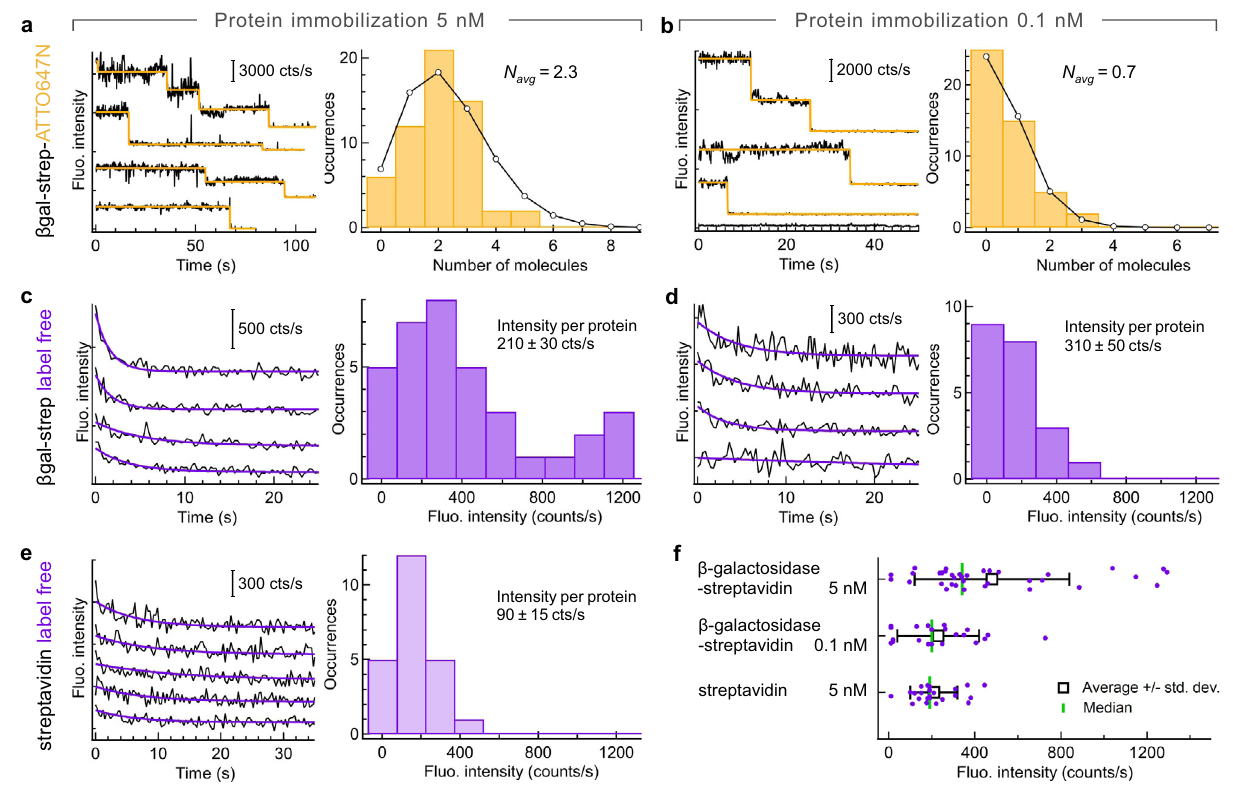
Fig. 2 Horn antenna-enhanced label-free detection of immobilized single proteins. The surface of the horn antenna has been functionalized with biotin- PEG-silane to bind β -galactosidase-streptavidin and pure streptavidin proteins. In ( a , c , e ), the total protein concentration is 5 nM while it is reduced to 0.1 nM in ( b , d ). a , b Additional Atto647N-biotin red fl uorescent label is added as a control to quantify the number of proteins inside individual horn antennas. Typical Atto647N fl uorescence time traces are shown on the left panels in ( a , b ), together with their step-function fi t (yellow line) allowing to count single molecules. The traces are vertically shifted for clarity. The right panels in ( a , b ) display the histogram of the number of detected molecules (bars) together with a Poisson distribution fi t (line and dots). For ( c – f ), the experiments are performed with label-free proteins in the UV using 5 nM β - galactosidase-streptavidin ( c ), 0.1 nM β -galactosidase-streptavidin ( d ) and 5 nM streptavidin ( e ). In ( c – e ), the left panels show auto fl uorescence time traces and their exponential decay fi t recorded on different individual horn antennas (the traces are vertically shifted for clarity). The right panels represent the histogram of the exponential fi t amplitudes. For ( c ) 35 horn antennas were probed, for ( d ) 21 and ( e ) 23. ( f ) Scatter plot of the exponential fi t amplitudes corresponding to the histograms in ( c – e ). The points are vertically shifted using a uniform statistical distribution to better view the results. The white square marker denotes the average value with the bars extending to one standard deviation. The green vertical line indicates the median. Respectively, 35, 21, and 23 antennas were probed for the different cases from top to bottom. Throughout these experiments, the cone angle is 32° and the aperture diameter is 200 nm (see Supplementary Fig. S13 for a discussion on the aperture